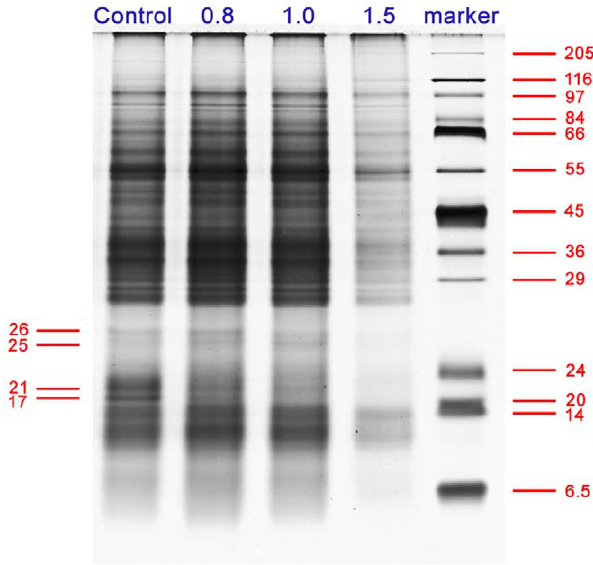
Figure 5. Protein expression profiles of Cedrusdeodara pollen tubes cultured in the presence of different concentrations of anti-CaM ( m g/mL). Proteins were extracted from pollen tubes incubated in standard medium (control) and in media containing 0.8, 1.0, or 1.5 m g/mL anti-CaM. Equivalent protein samples were separated by SDS-PAGE electrophoresis on 12% polyacrylamide gels (1 mm thick). Four bands showing significant changes in their expression levels were excised and subjected to further MS